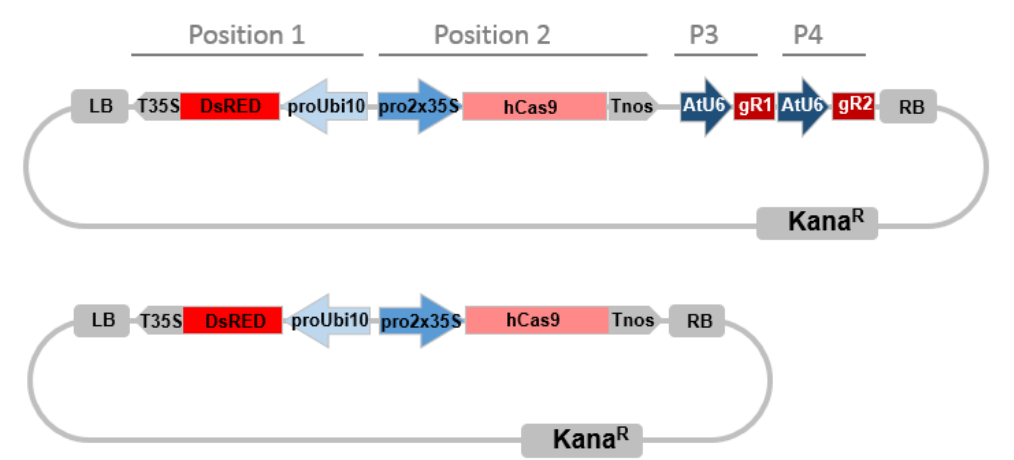
Figure 6. CRISPR / Cas9 binary vector targeting two loci simultaneously. Promoters are indicated in blue arrows, terminators are indicated in gray arrows. Pro2x35, double Cauliflower mosaic virus CaMV 35S promoter; AtU6 , Arabidopsis thaliana U6 gene promoter; hCas9 , human codon-optimized Cas9 gene sequence from Streptococcus pyogenes ; LB, left T-DNA border; Kana R , kanamycin resistance gene sequence; DsRed, DsRed fluorescent marker gene sequence, ProUbi10 Arabidopsis thaliana Ubiquitin 10 gene promoter; T35S , terminator region of CaMV35S gene; TNos , terminator region of the nopaline synthetase gene from Agrobacterium tumefaciens ; RB, right T-DNA border, P3, Position 3; P4, Position 4, miss description of the gRNA. The bottom construct is the Cas9 control plasmid without sgRNA.